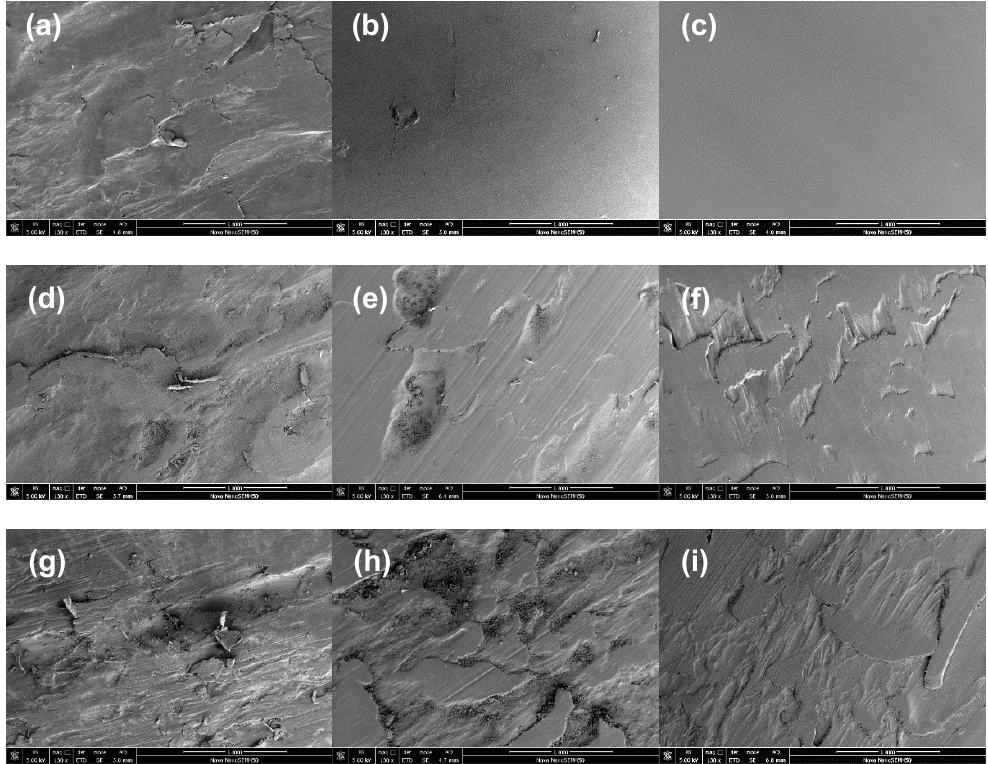
Figure 8. SEM images of the worn surface morphological features of pure ABS, ABS/GO and ABS/HBP-m-GO after ( a – c ) 1000, ( d – f ) 4000 and ( g – i ) 10,000 sliding cycles , respectively.